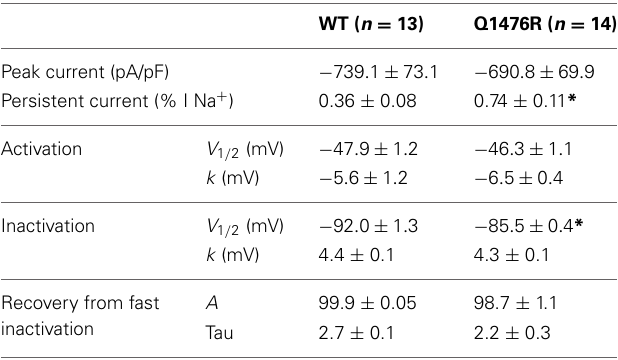
Table 1 | Biophysical properties of Na v 1.5/WT and